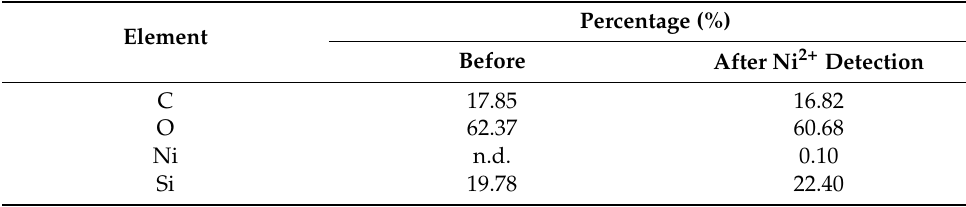
Table 1. Elemental composition data of sensor